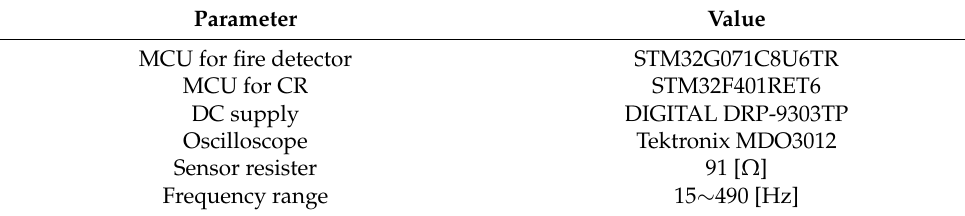
Table 2. Experimental